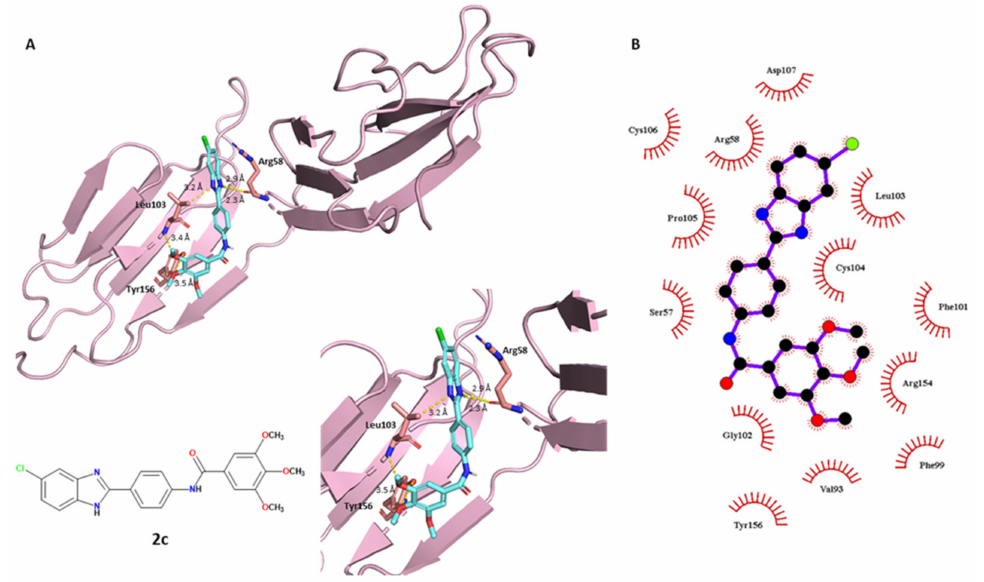
Figure 4. Conformational representation of the best-docked pose of compound 2c . ( A ) Protein–ligand polar interactions between 2c and the exposed amino acids of E2, investigated in PyMOL. Protein is depicted in a light-pink tint, compound 2c is in blue marine. Polar contacts are reported as yellow dashes. ( B ) Non-polar interactions between 2c and E2, generated through LigPlot + . Colors: black (carbon), blue (nitrogen) and red